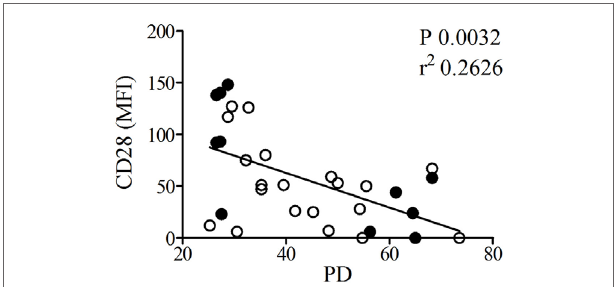
FigUre 1 | The population doublings (PDs) of T cell clones inversely correlate with CD28 expression. CD4 + T cell clones used for small RNA sequencing (filled symbols) with high and low PD and additional T cell clones (open symbols) were fluorescence-activated cell sorting analyzed for expression of CD28. Shown is the relation between CD28 expression based on mean fluorescence intensity (MFI) and PD of the T-cell clones. For one of the clones no MFI data are